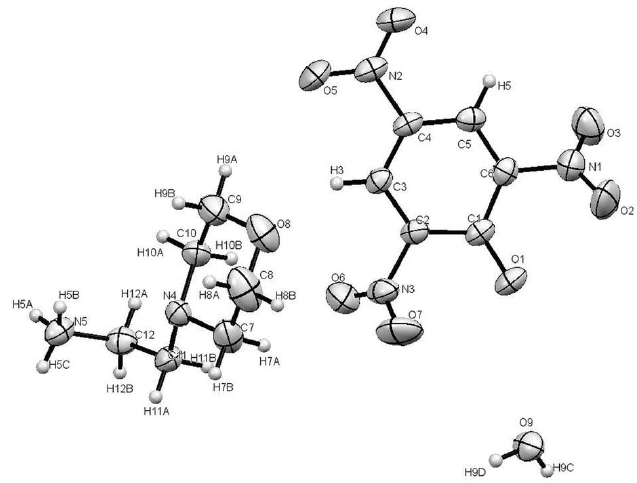
Figure 2 ORTEP diagram of the title compound with the atom-numbering scheme. Displacement ellipsoids are drawn at the 50% probability level.